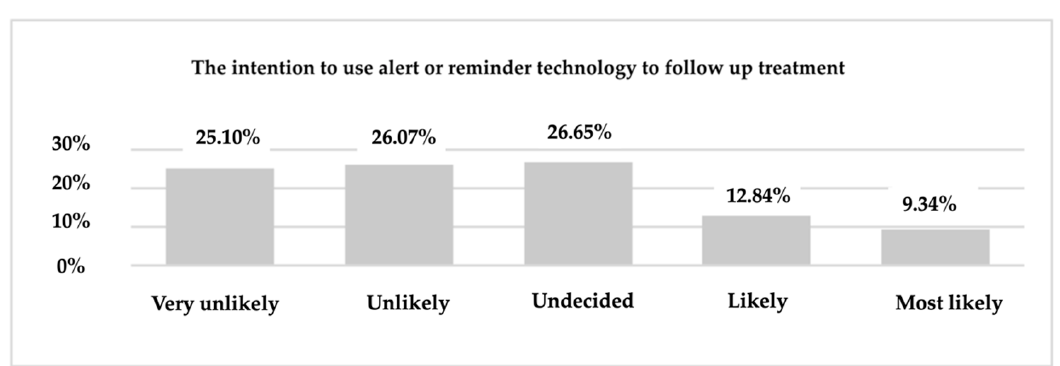
Figure 13. The intention of using technology—alerts or reminders for follow-up treatment.